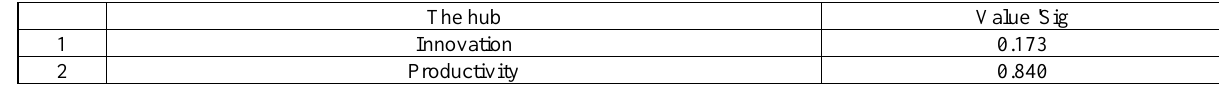
Table 11. The natural distribution test for the axes of achieving strategic goals The